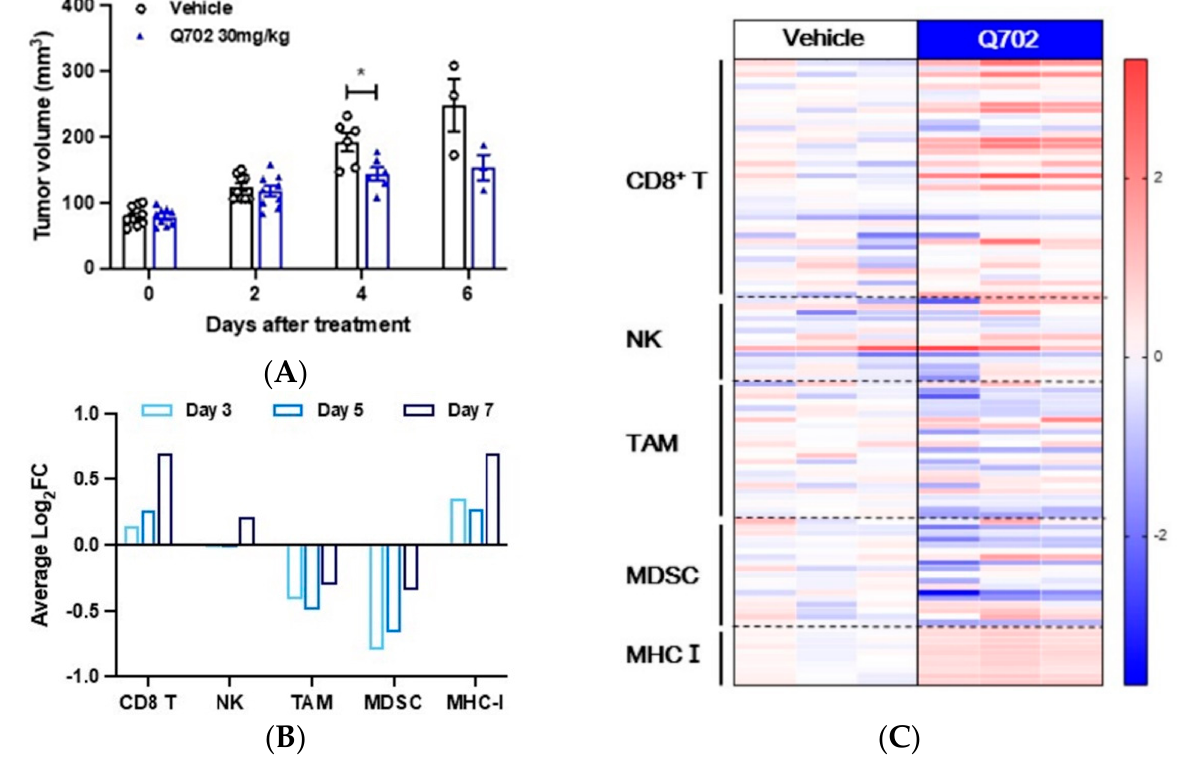
Figure 2. Q702 shows antitumor activity in an EMT6 syngeneic mouse model. ( A ) EMT6, mouse triple-negative breast cancer cells were treated with Q702 at the indicated concentrations for 72 h. Cell viability was measured using the CellTiter-Glo assay system. Luminescence units were normalized to those of untreated cells and are presented as the percentage of cell growth inhibition. IC 50 , the inhibition concentration of a drug where the response is reduced by half. ( B ) EMT6 (1 × 10 6 ) cells were inoculated subcutaneously into the left flank of BALB/c mice. When the tumor size reached 60–80 mm 3 , mice were randomized and treated with vehicle or Q702 (10, 30, or 100 mg/kg) orally once daily for two weeks (N = 8/group). Tumor volumes were measured from the start of treatment and the results are shown as mean ± SEM. *** p < 0.001, **** p < 0.0001, one-way ANOVA.